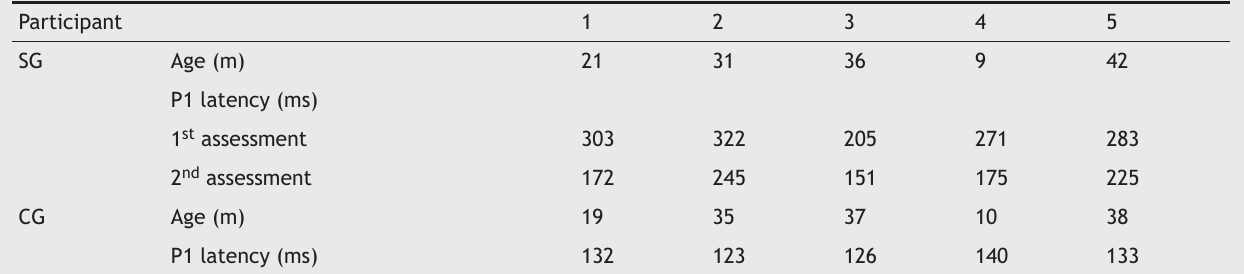
Table 3 Description of age and latency values obtained with cortical auditory evoked potential for the study group and control